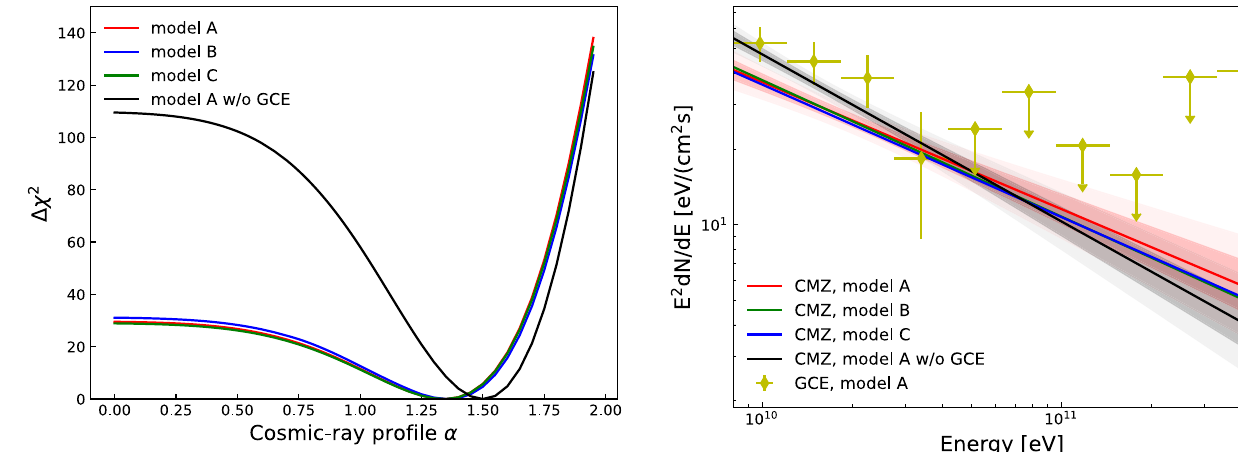
Fig. 5 Energy fl uxes of γ -ray emission from neutral pion decay associated with H 2 in the CMZ region. To test the robustness of the results, different GDE models of the other emission components, such as the templates for emissions from the inverse Compton scattering or the neutral pion decay in the off-CMZ region, are used in the fi tting. With the CS × r − 1.35 template, the red solid line and associated dark and light bands are for results using GDE model A. The blue and green solid lines are for results using GDE model B and GDE model C, respectively. The black band and line are for the fi tting using GDE model A but without incorporating the GCE. The SED of the GCE component is also shown in yellow points for reference. Dark and light regions show the 68 and 95% con fi dence ranges of the power-law fi tting spectrum, respectively. The error bars represent the 1 σ statistical uncertainties and the upper limits are at the 95% con fi dence level. Source data are provided as a Source Data fi